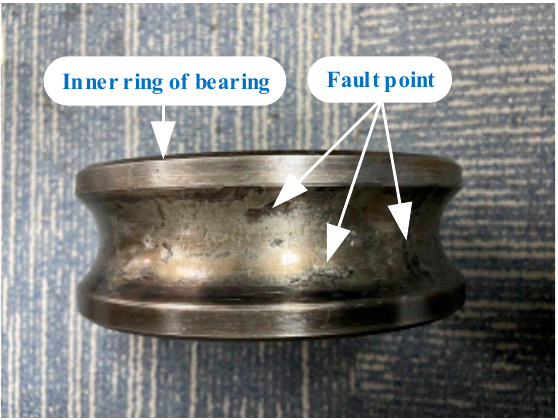
Figure 10. The inner ring fault of rolling bearing at driving end of wind power generator.